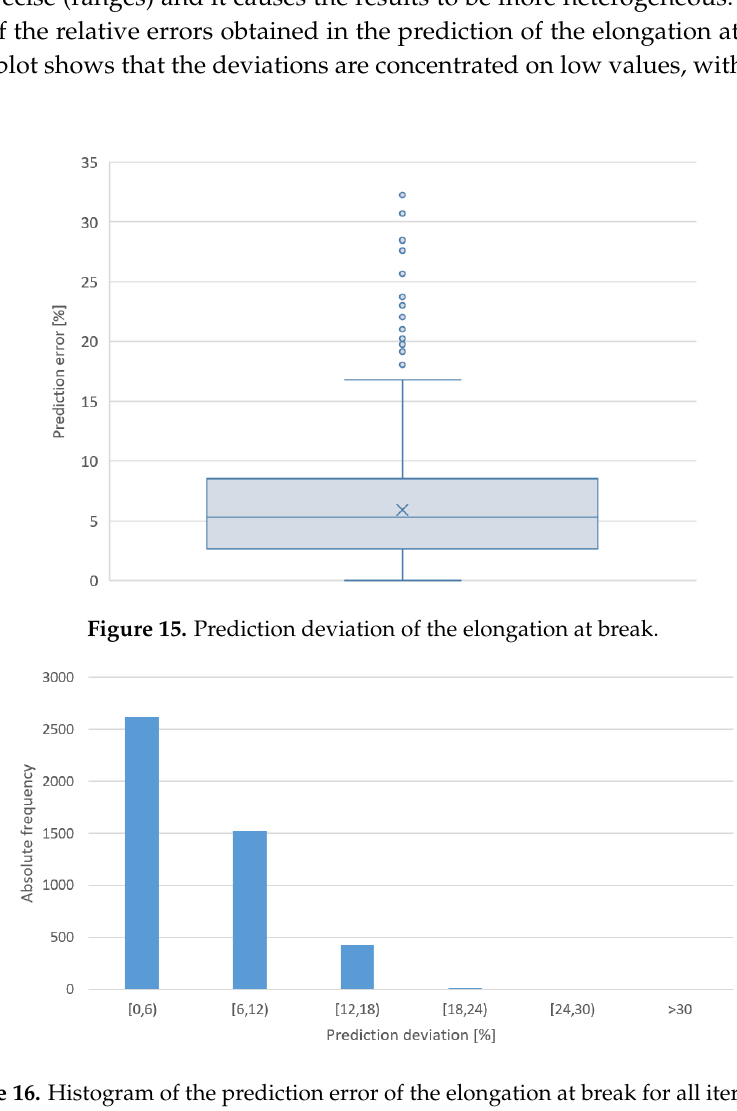
Figure 16. Histogram of the prediction error of the elongation at break for all